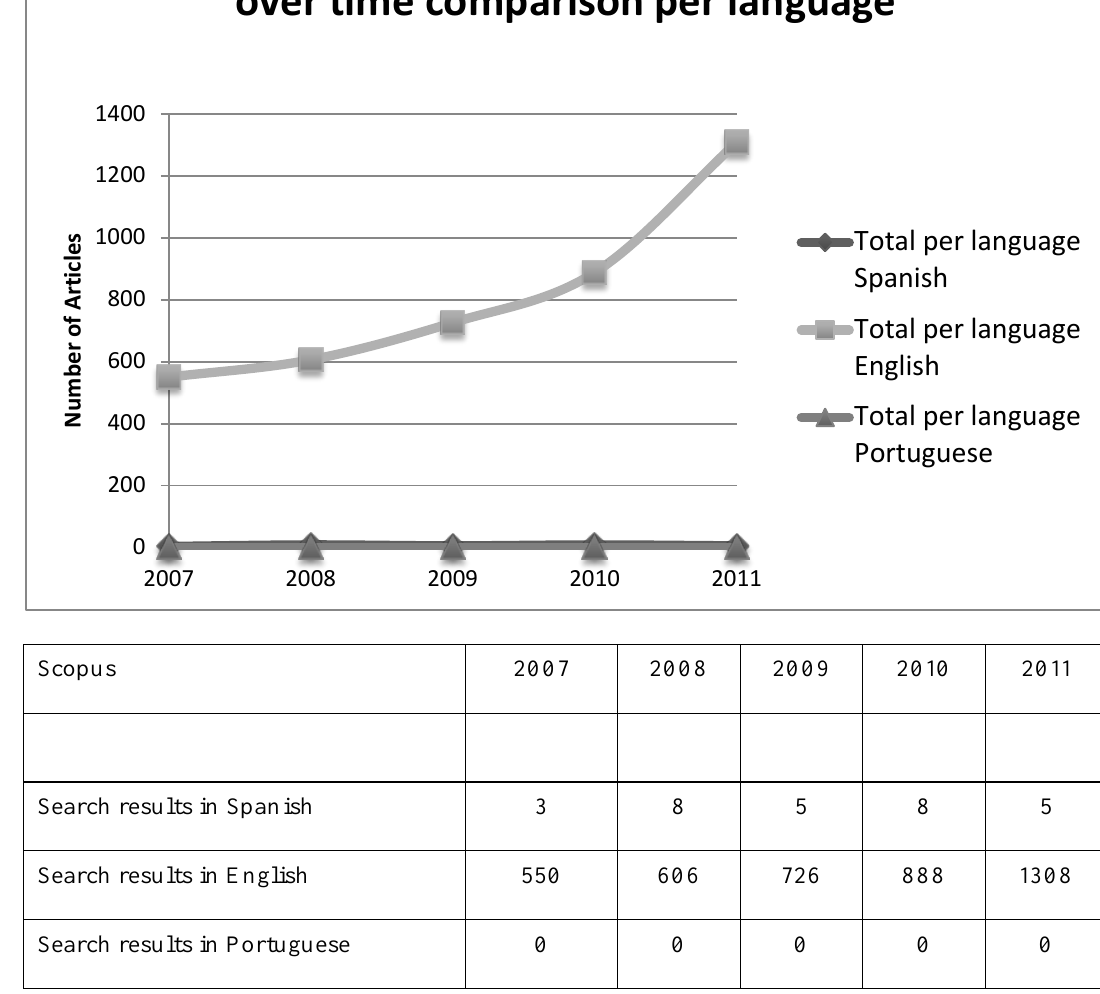
Figure 2 . Scopus: Over time comparison per language